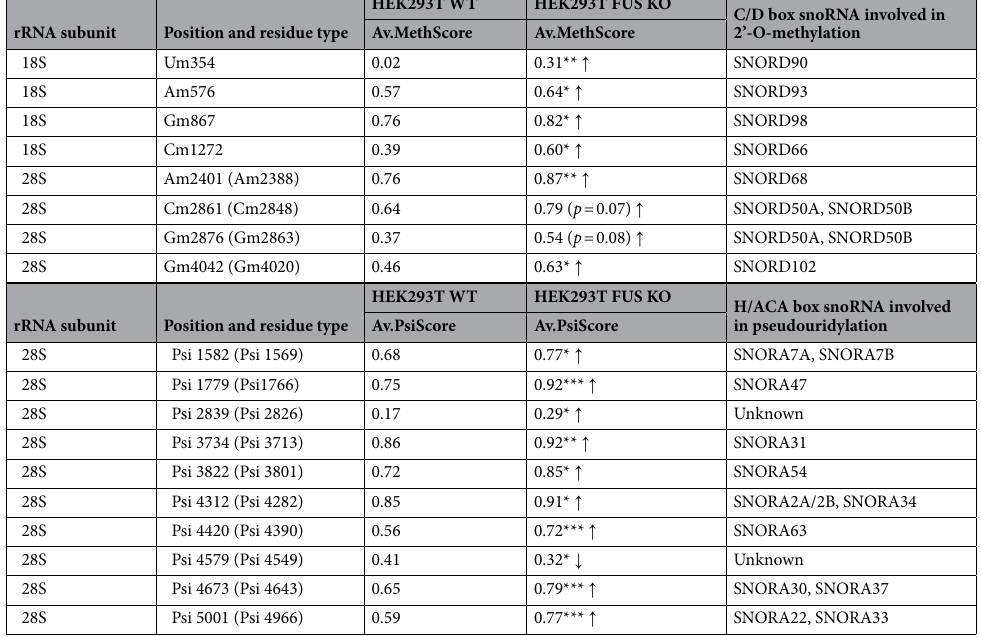
Table 1. 2’-O-Me and pseudouridylation positions changed in 18S and 28S ribosomal RNAs in HEK293T WT and FUS KO cell lines. The MethScores and the PsiScores represent the average of three biological replicates and describe a fraction of molecules methylated and pseudouridylated at a given position, respectively. The old nomenclature is shown in brackets. Arrows depict the direction of modification changes in FUS KO cells relative to WT cells. P values were calculated using paired Student’s t -test, and the statistical significance is represented as follows: * p ≤ 0.05; ** p ≤ 0.01; *** p ≤ 0.001.